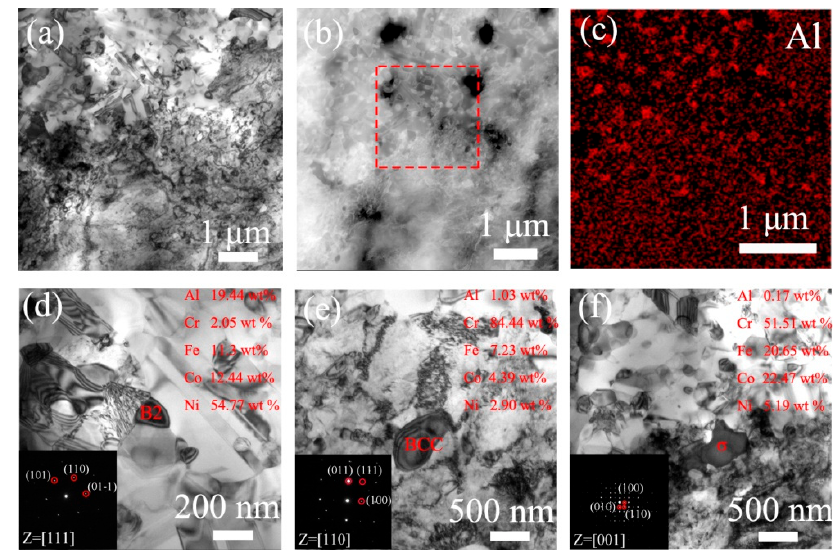
Figure 5. TEM images of AR590 sample: ( a ) BF image, ( b ) STEM image, ( c ) elemental energy dispersive mapping, ( d ) B2 precipitate with SADP and composition, ( e ) BCC precipitate with SADP and composition, ( f ) σ precipitate with SADP and composition.